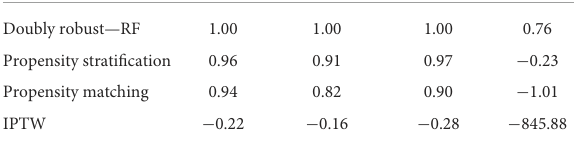
TABLE 2 Model evaluation results on hybrid dataset. TABLE 3 Model evaluation results on synthetic